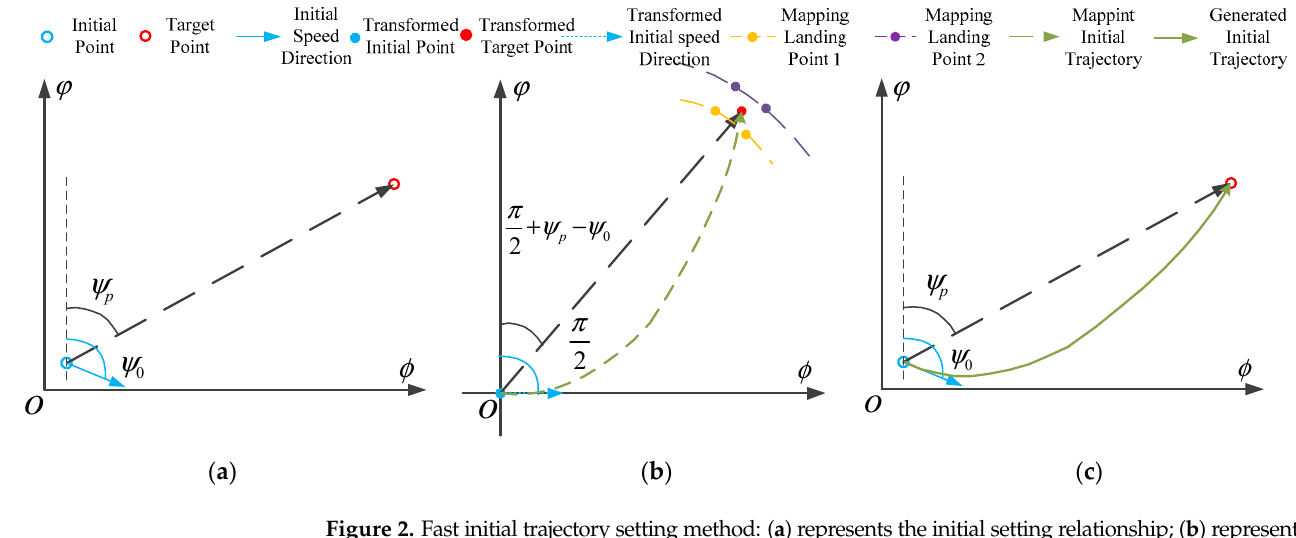
Figure 2. Fast initial trajectory setting method: ( a ) represents the initial setting relationship; ( b ) represents the transformed mapping relationship; ( c ) represents the generated initial trajectory.